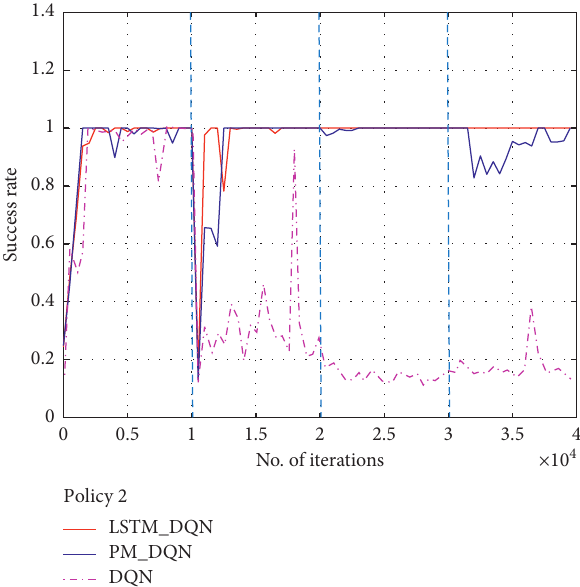
Figure 7: Relationship between the number of iterations and reward function (policy 2).